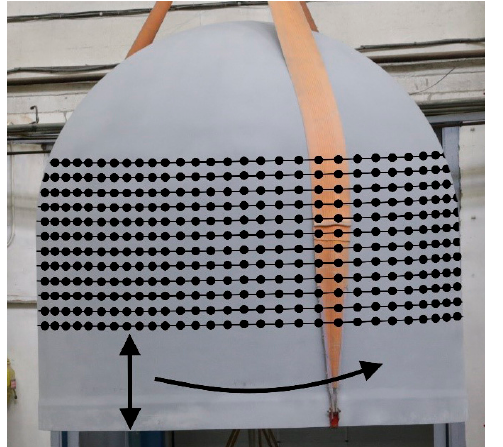
Figure 1. Stages of performance study.